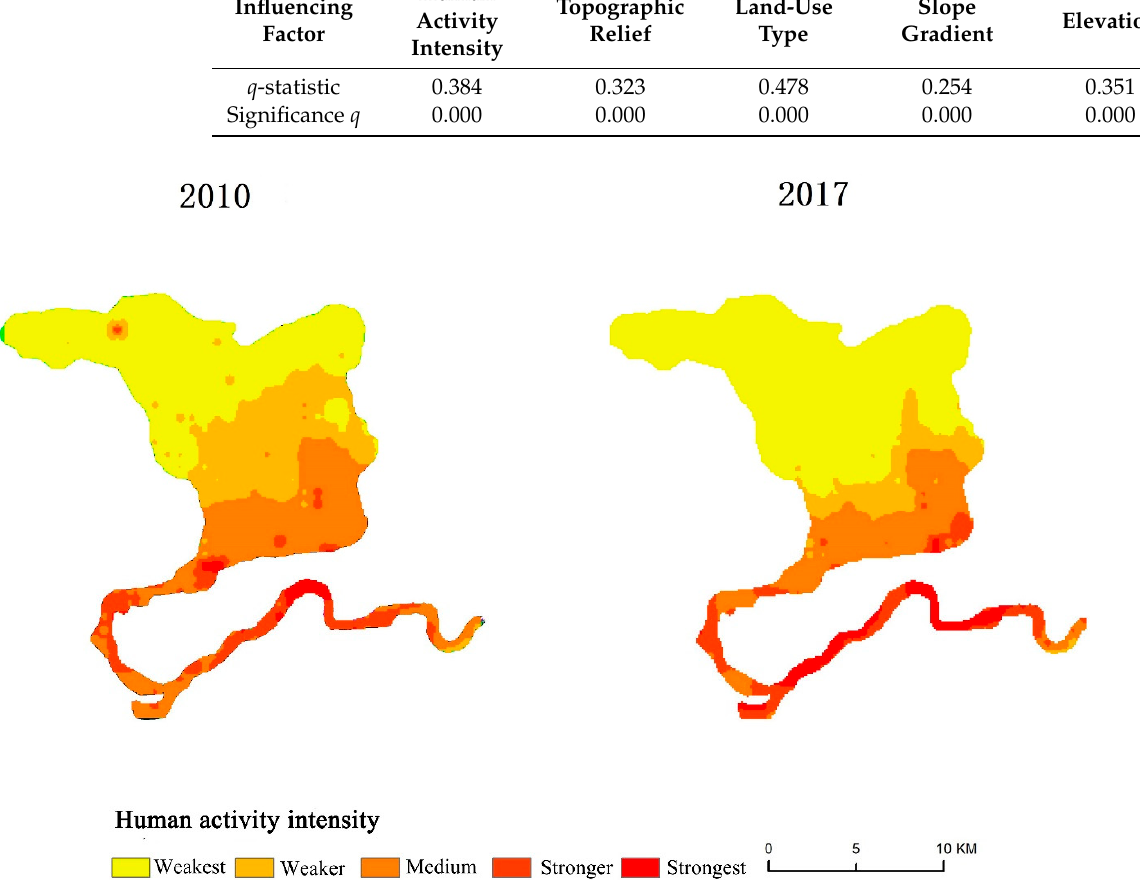
Figure 5. Intensity of human activities in the Hanzhong Crested Ibis nature reserve.